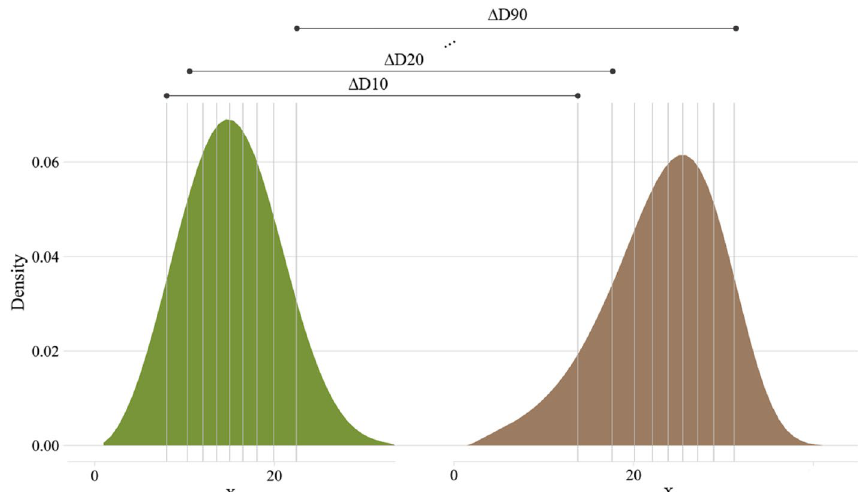
Fig. 3 An illustration on how two tree size distributions of a harvested segment were compared using the observed decile values (D10, …, D90) associated with the fitted Weibull distributions. x, height or diameter at breast